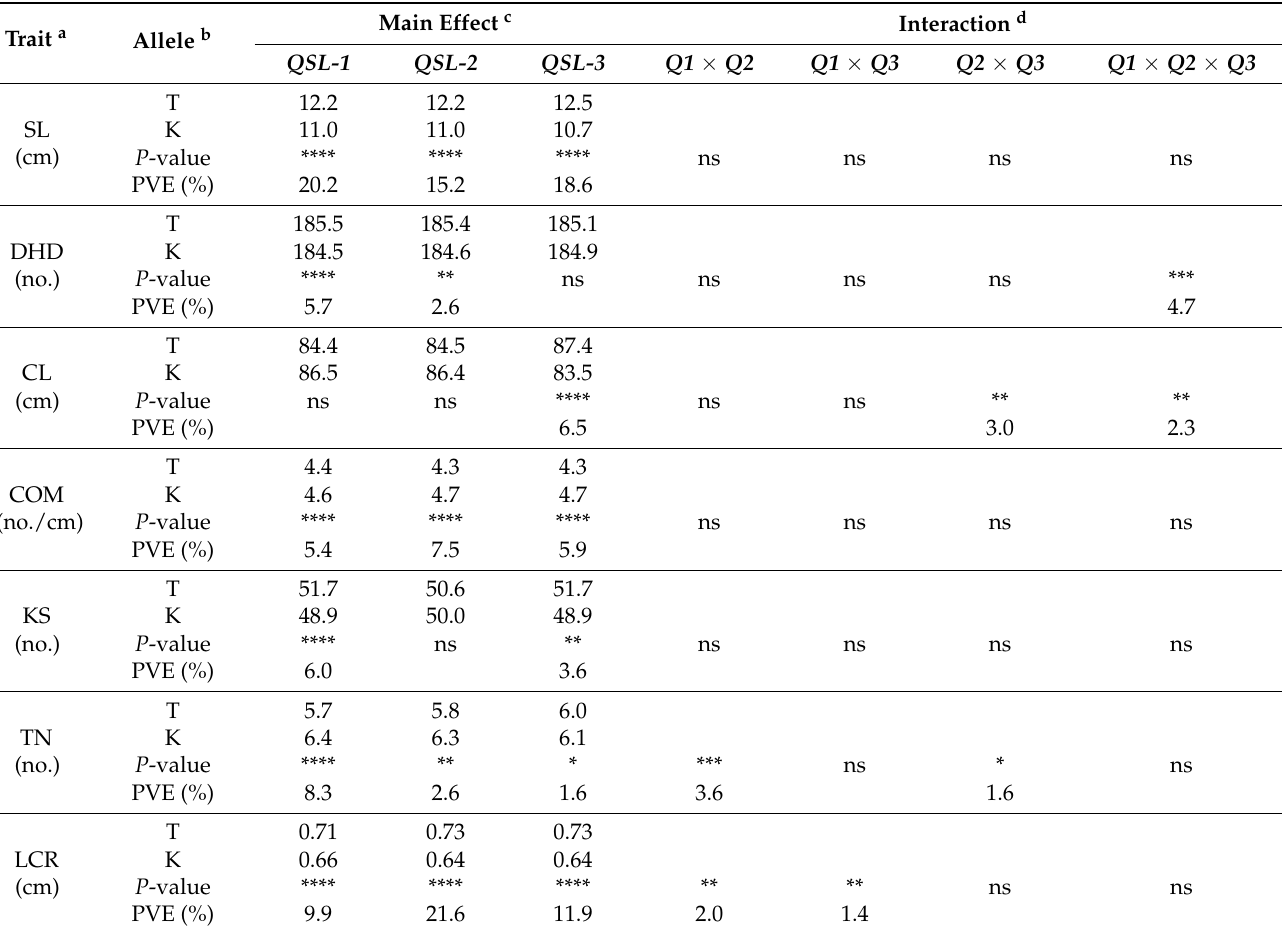
Table 2. Three-way ANOVAs of QSL-1 , QSL-2 , and QSL-3 for different yield potential